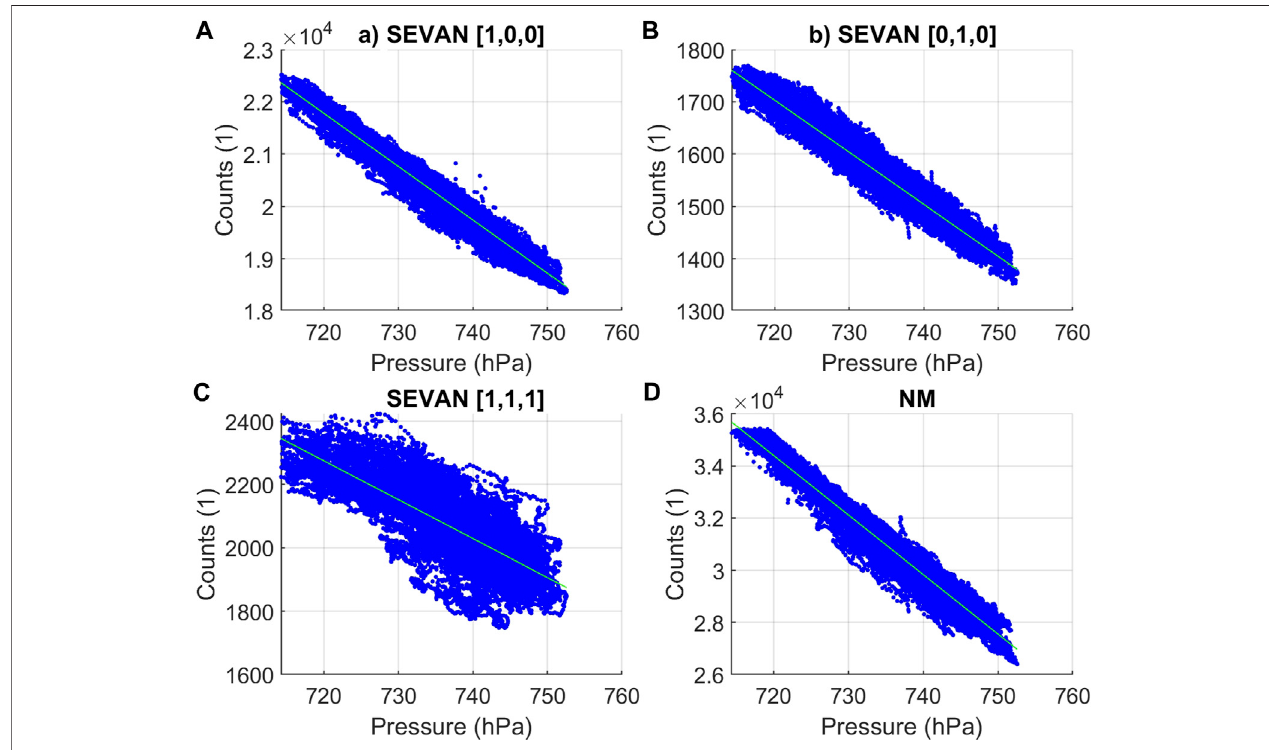
FIGURE 1 | Scatterplots between measured counts (2-h mean values of 1-min data) and atmospheric pressure on LS. Green lines indicate linear regressions. (A) SEVAN [1,0,0] combination, (B) SEVAN [0,1,0] combination, (C) SEVAN [1,1,1] combination, and (D) NM.